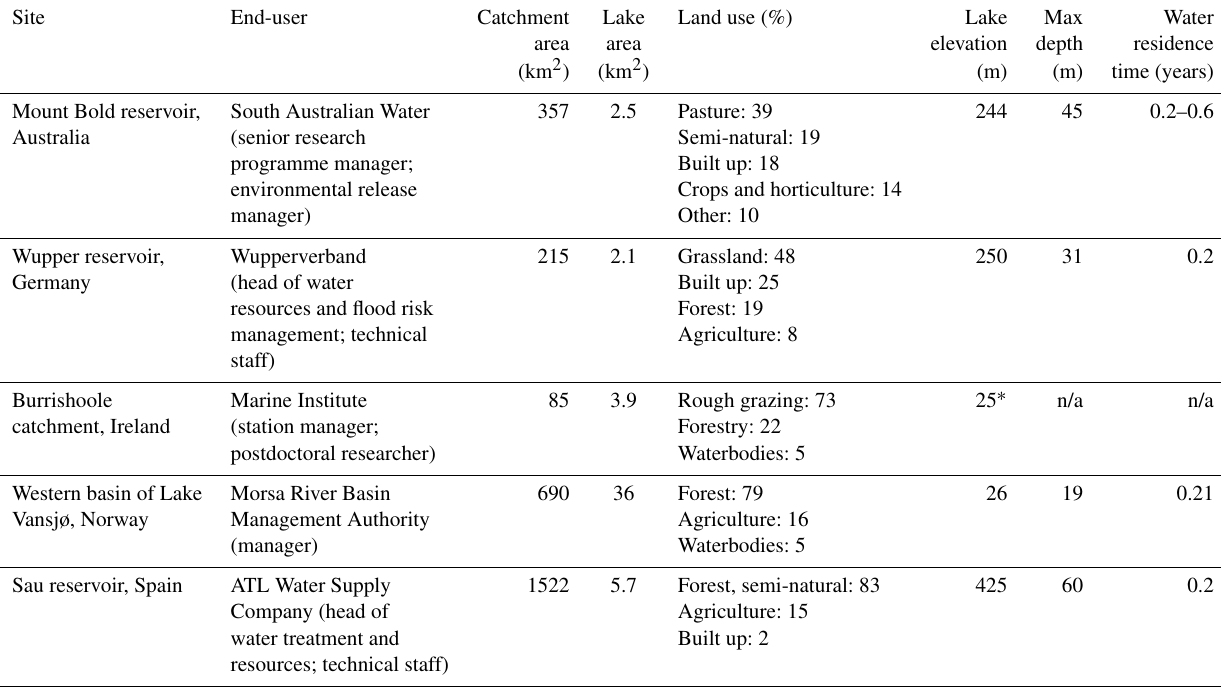
Table 1. Main characteristics of the catchment–lake study sites and a description of the water managers involved in the project.